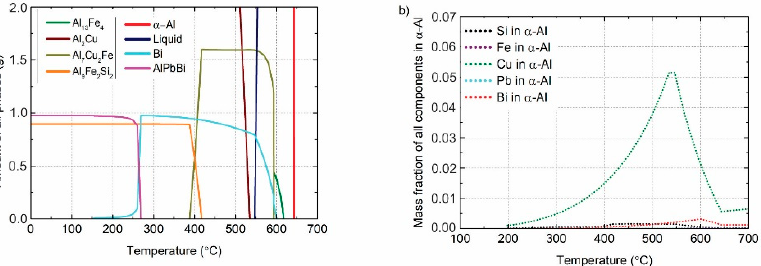
Figure 1. Thermo-Calc predicted phase stability ( a ) and element solubility in α -Al matrix ( b ) in aluminium alloy EN AW 2011 with respect to temperature.